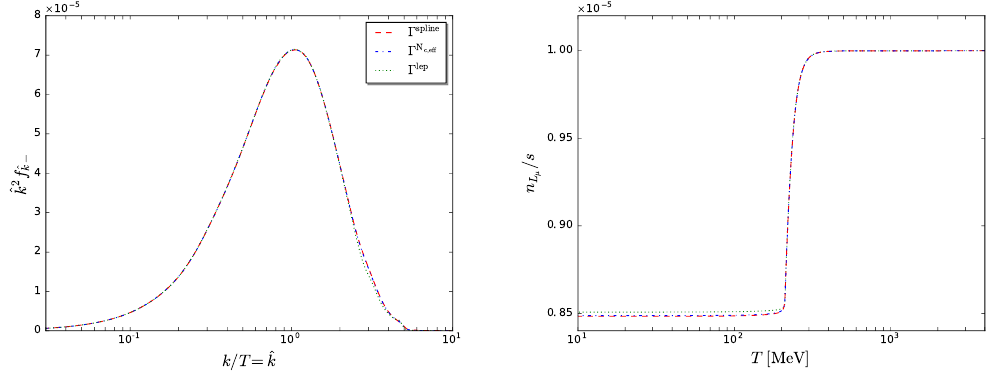
Figure 2 . Same as (cid:12)gure 1 but with a higher initial lepton asymmetry. The fraction of the dark matter energy density in all three cases is roughly (cid:10) s = (cid:10) DM = 2 : 5 (cid:1) 10 (cid:0) 2 .